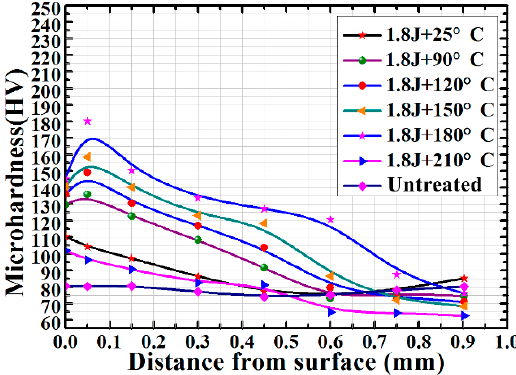
Figure 5. Hardness distribution in depth .